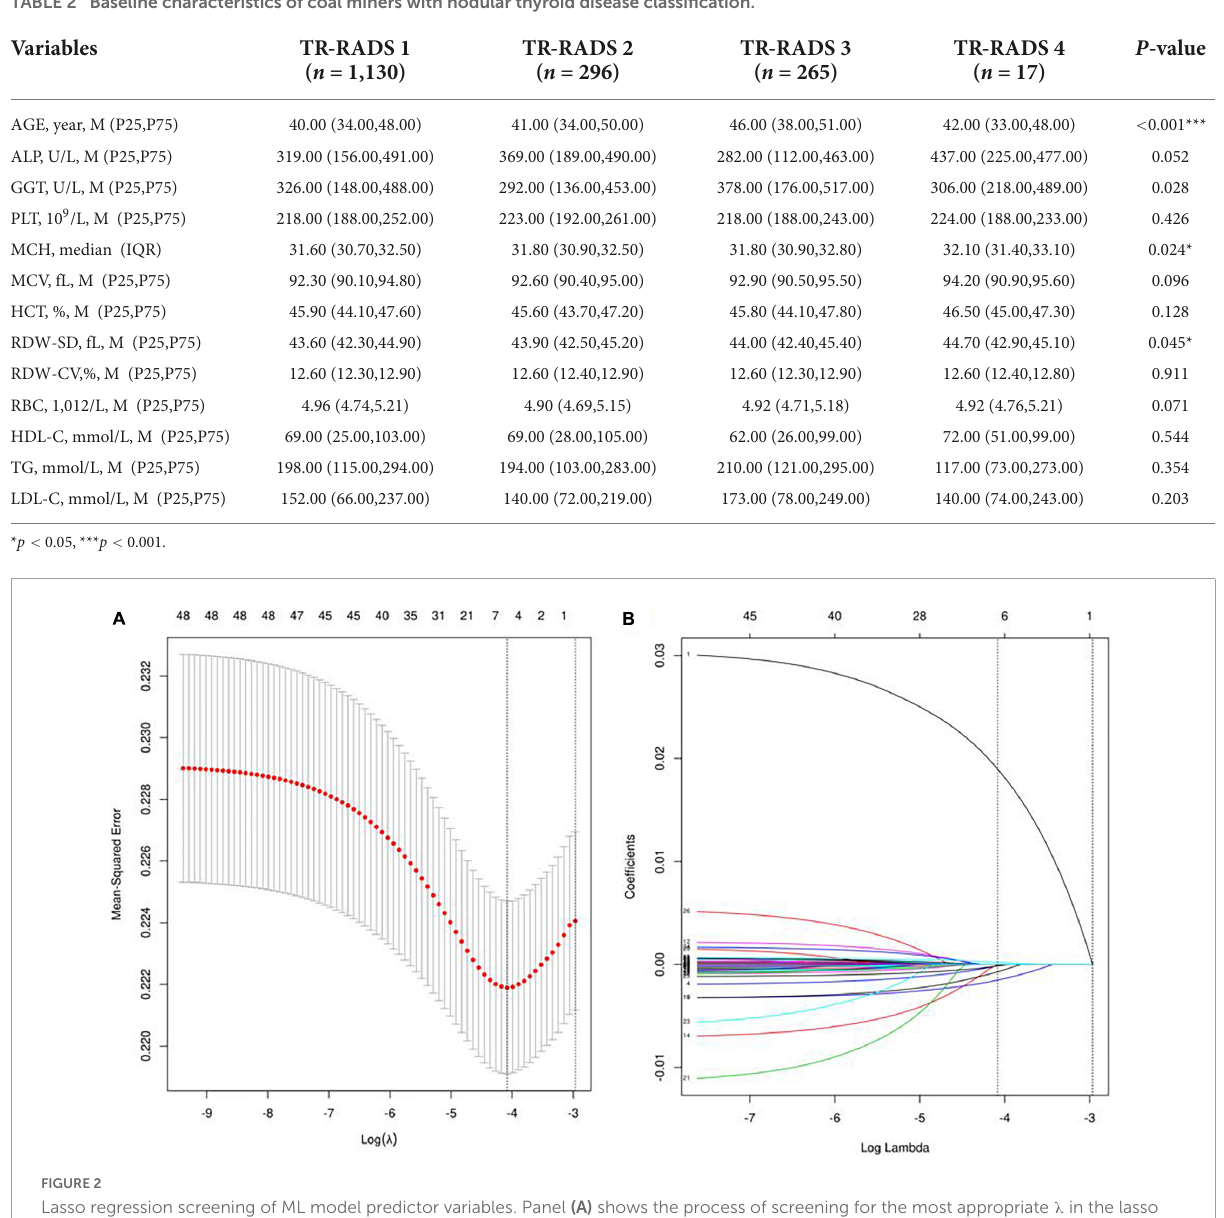
TABLE 2 Baseline characteristics of coal miners with nodular thyroid disease classification.